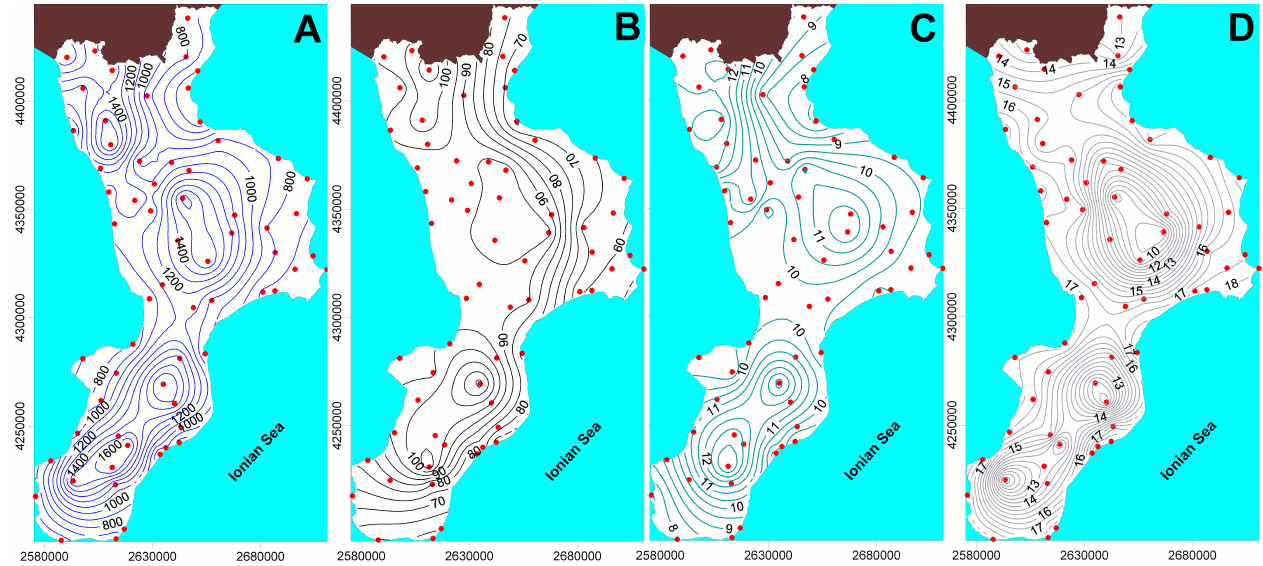
Fig. 4. Map of selected gauges (dots) and contour lines of the mean annual values of precipitation ( A , mm), wet days (B) , precipitation intensity ( C , mmday − 1 ), and temperature ( D , ◦ C).